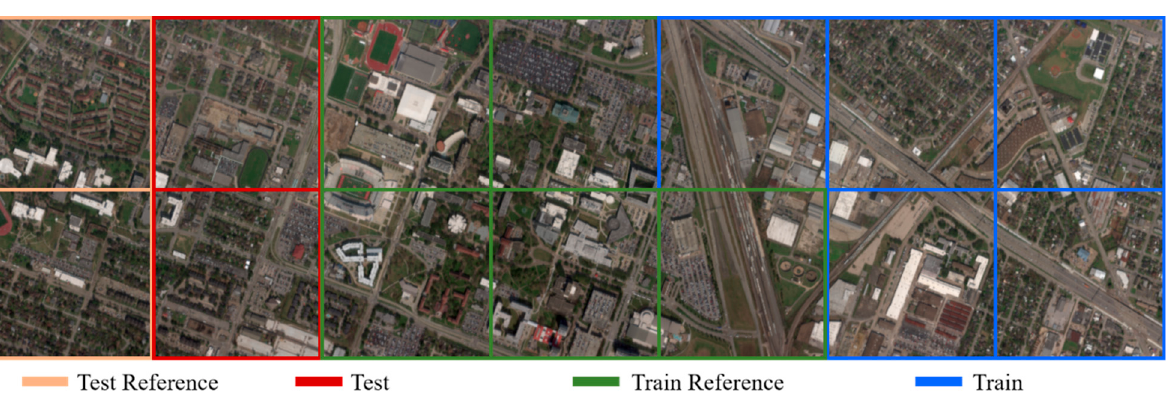
Figure 4. Original Pavia Centre and Pavia University data sets: ( a ) Pavia Centre; ( b ) Pavia Univer- sity. The border color indicates the purpose of the image.